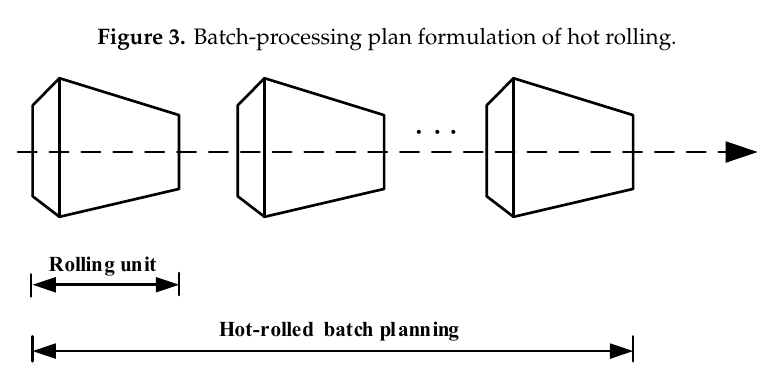
Figure 4. Schematic diagram of a batch-processing plan for hot rolling.